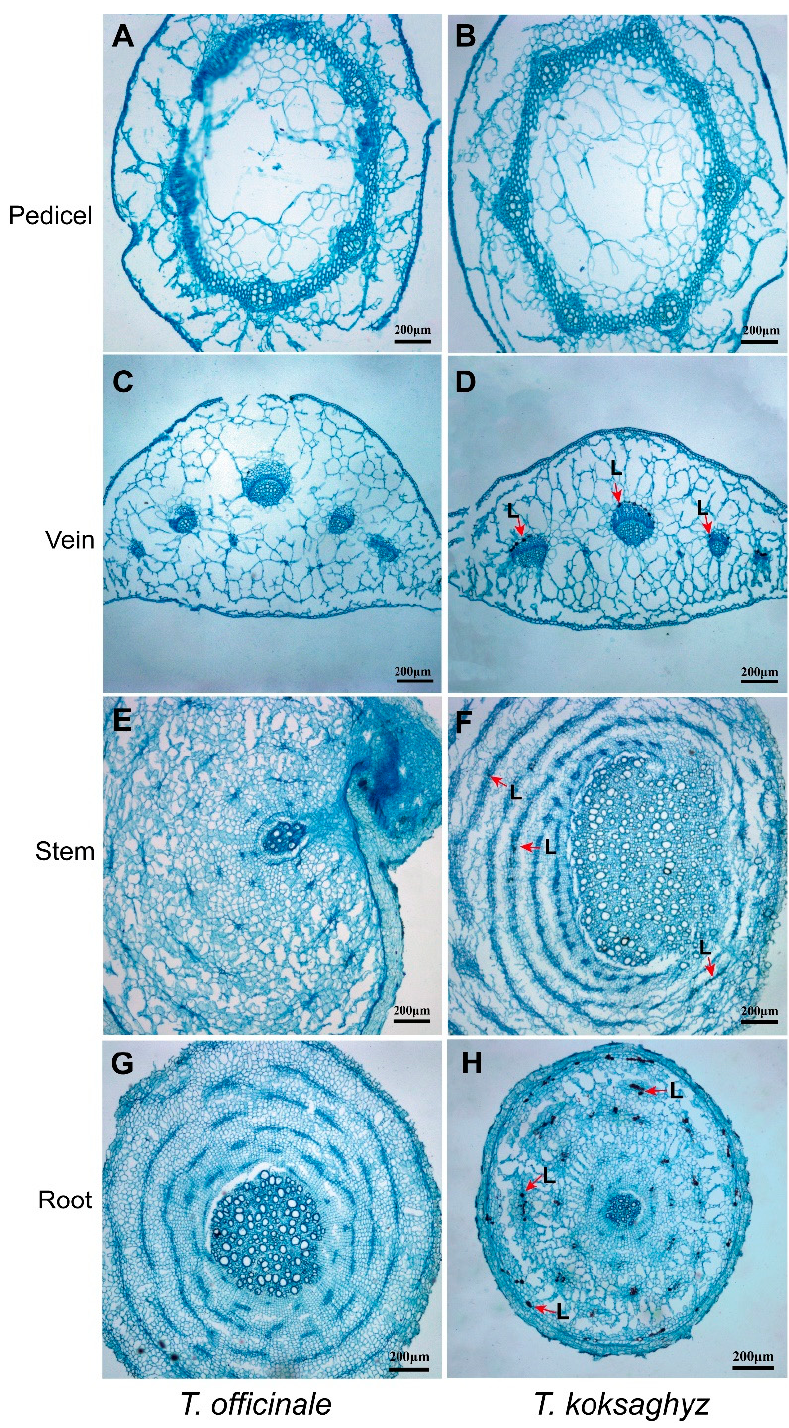
Figure 2. Morphological comparison of laticifer cells in different tissues of T. officinale and T. kok-saghyz . The laticifer cells containing brown rubber latex strands can be examined under a light microscope in the cross-cutting sections of the vein ( D ), stem ( F ), and main roots ( H ) in TKS, but no laticifers were observed in TKS pedicel ( B ) and in all the detected tissues in T. officinale ( A , C , E , G ).